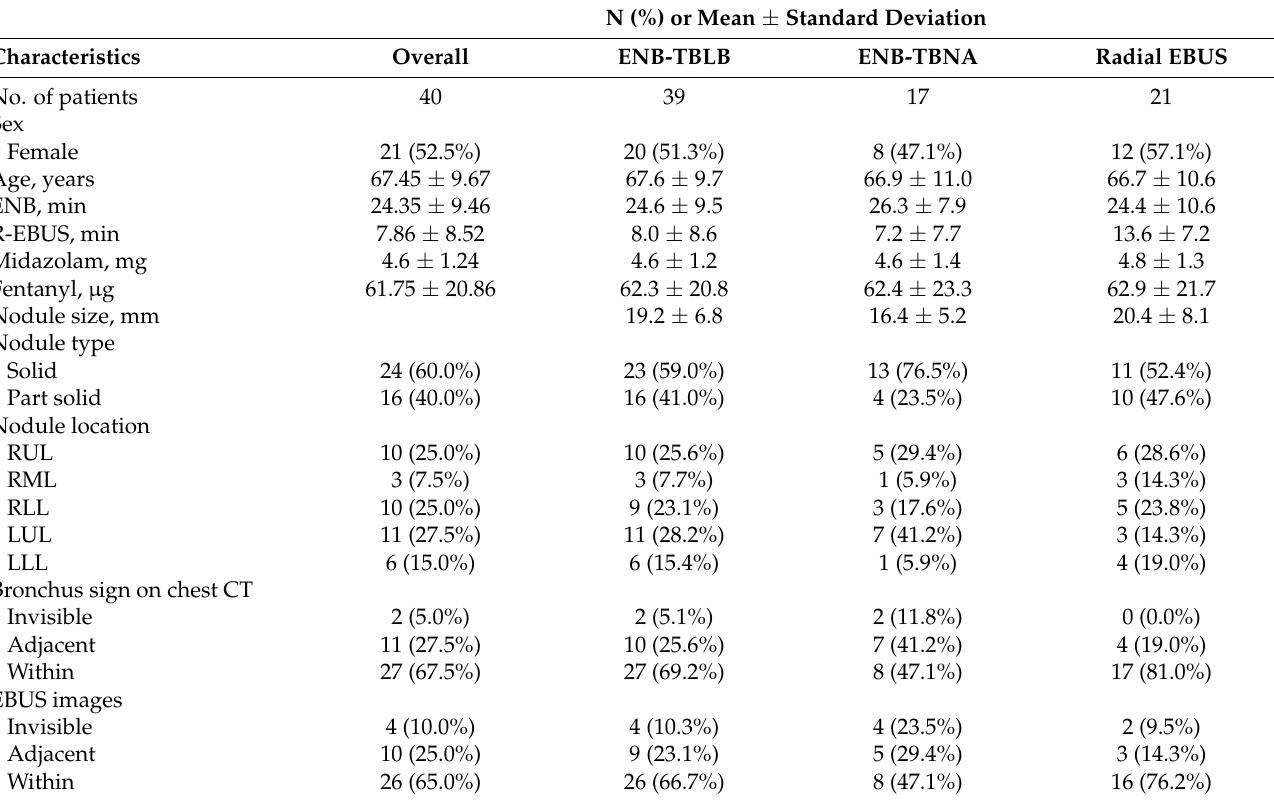
Table 1. Demographic and baseline